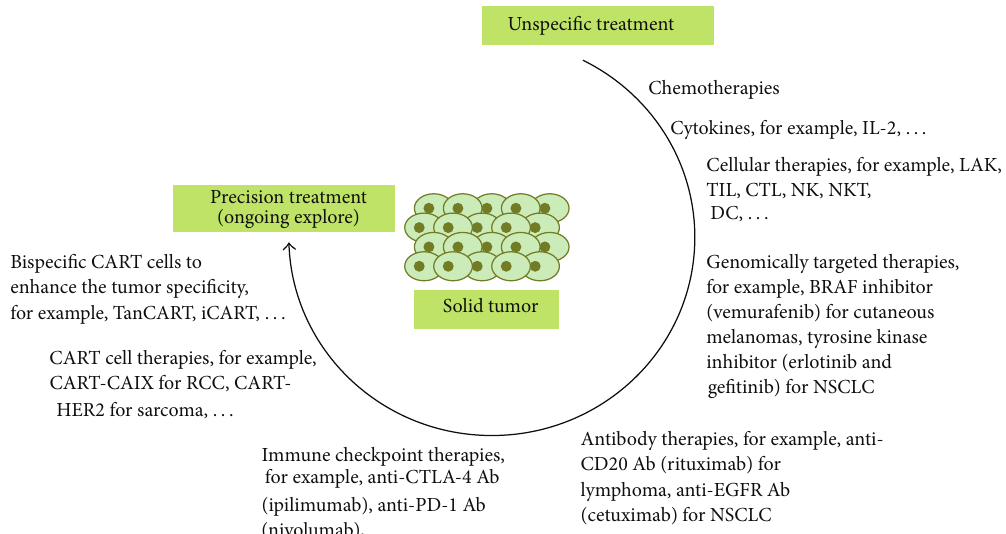
Figure 2: Development of precision treatment for solid tumor. Ab: antibody; CTL: cytotoxic T cells; CTLA-4: cytotoxic T lymphocyte- associated antigen-4; DC: dendritic cells; iCART: inhibitory signal-based antigen-specific CART cells; IL-2: interleukin-2; LAK: lymphokine- activated killer cells; NK: natural killer cells; NKT: natural killer T cells; NSCLC: non-small-cell lung cancer; PD-1: programmed death-1; TanCART: tandem CART cells; TIL: tumor-infiltrating